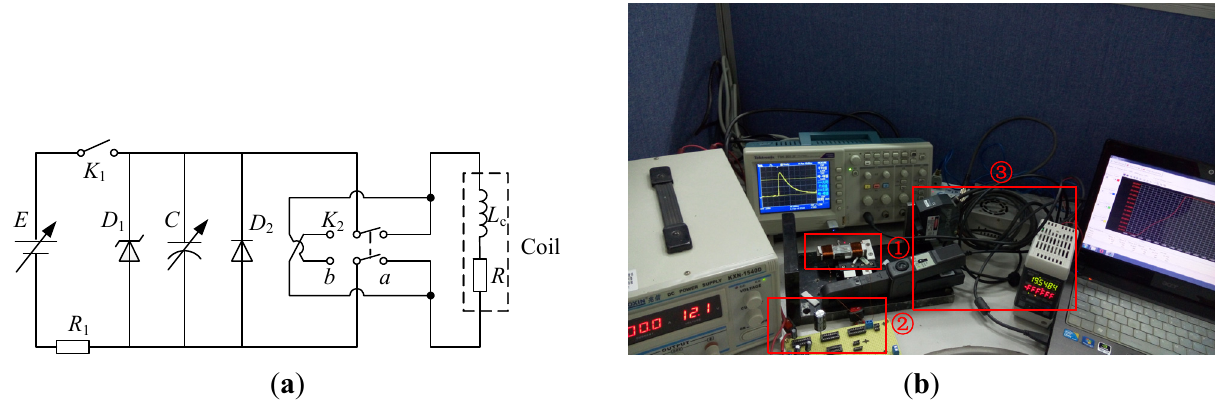
Figure 11. ( a ) Experimental circuit; ( b ) Experimental rig, ① Prototype, ② Capacitor supply, ③ Laser displacement transducer.